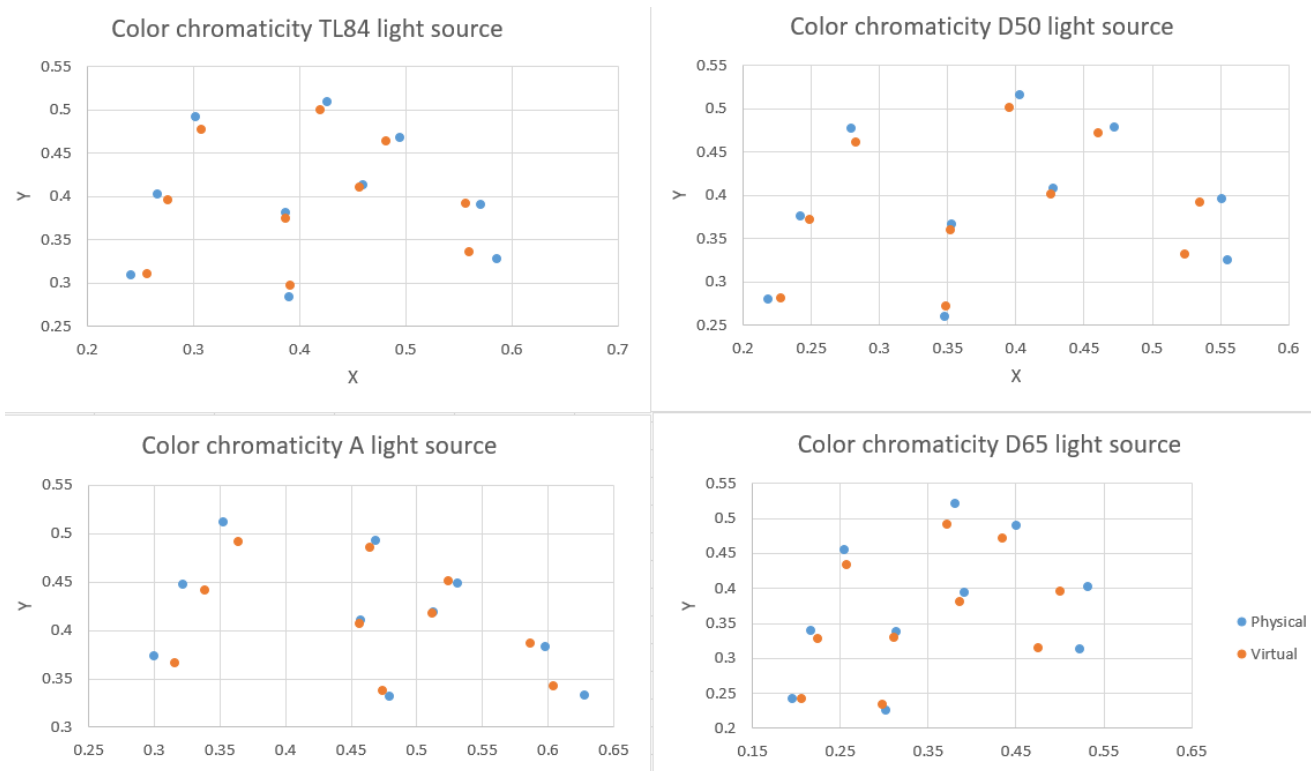
Figure 10. Different x,y chromaticity coordinates of NCS samples for different light sources. TL84 ( top left ), D50 ( top right ), A ( bottom left ) and D65 ( bottom right ).